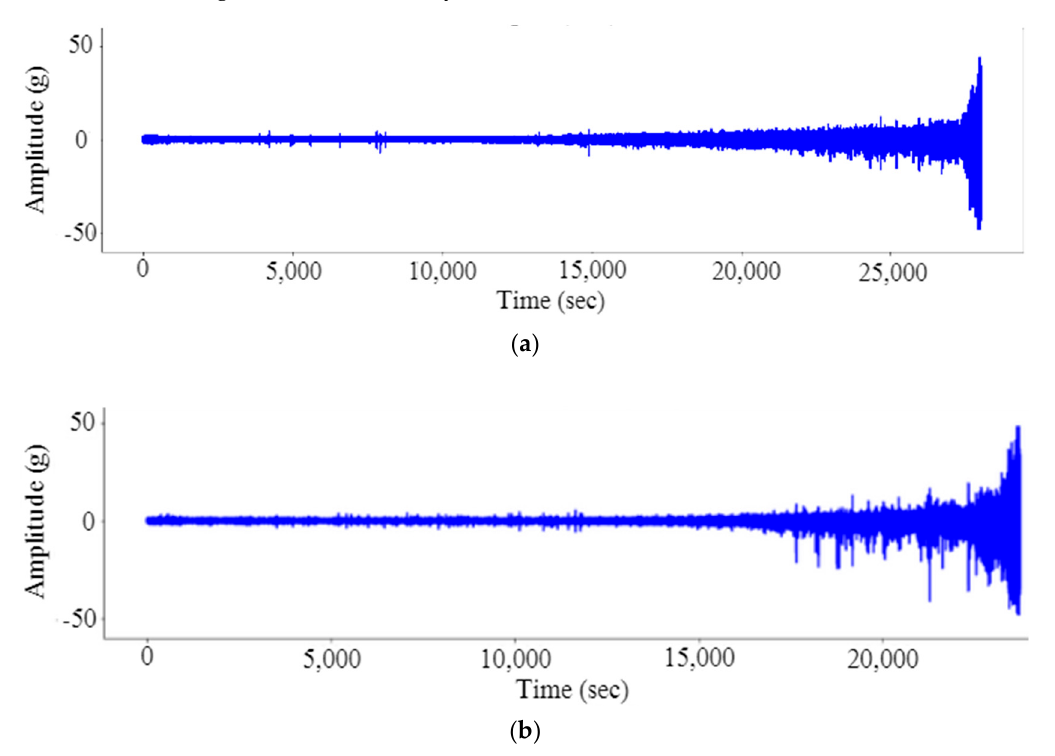
Figure 3. Vibration signal of ( a ) bearing 11 and ( b ) bearing 13 in the time domain.